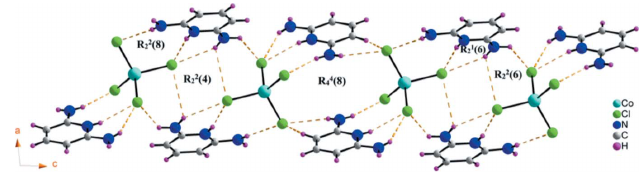
Figure 4 Projection of a part of the crystalline structure of the compound (I), showing the formation of the motifs R 2